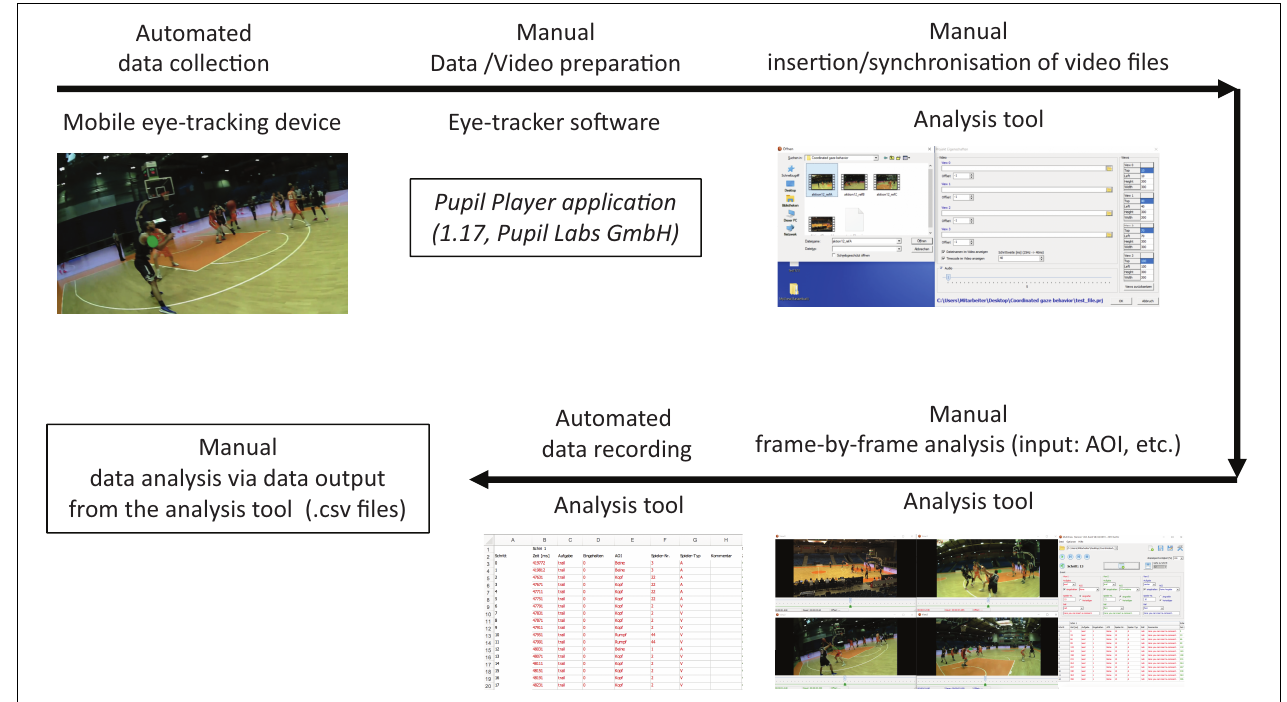
FIGURE 3 | Flow chart of the working process for analyzing gaze coordination in dynamic events using the new tool.